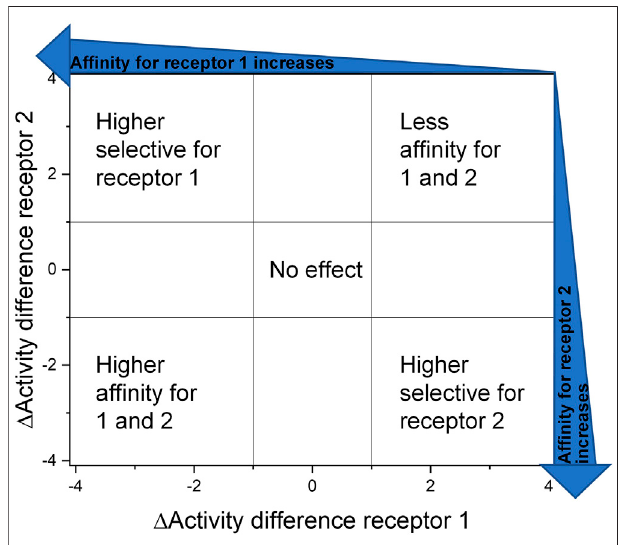
FIGURE 7 | Dual activity and difference map according to Medina- Franco(2012).Theareaswereselectedtoassessandpresenttheeffectofthe structural change they are visible as data points in the corresponding